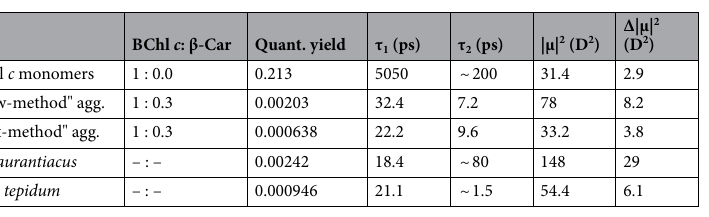
Table 1. Quantum yields, lifetimes of the DAS components, emitting dipole strengths (calculated using ε r = n 2 and (cid:31) air = c ν in Eq. (2) and combining Eqs. (1) and (2) into errors.